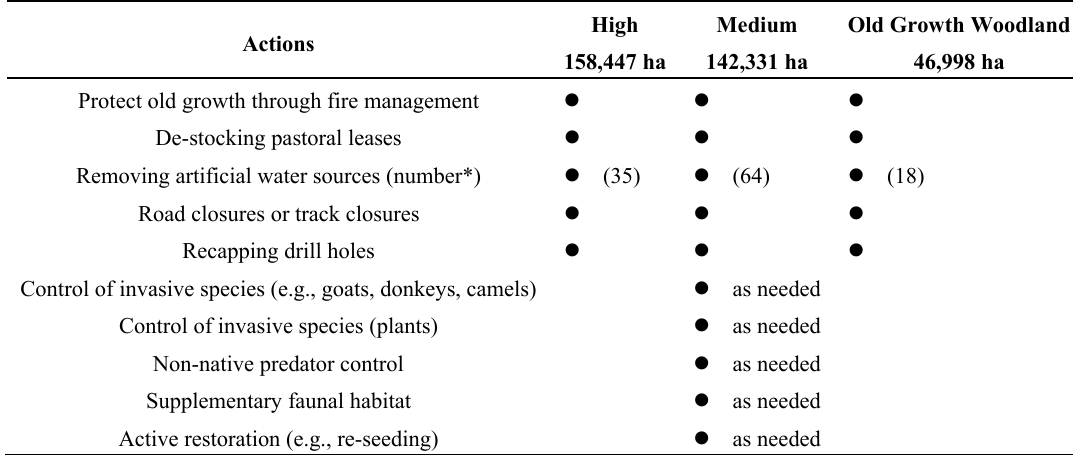
Table 3. Distribution of pastoral lease area by habitat type (old growth) and condition (high/medium) and possible offset